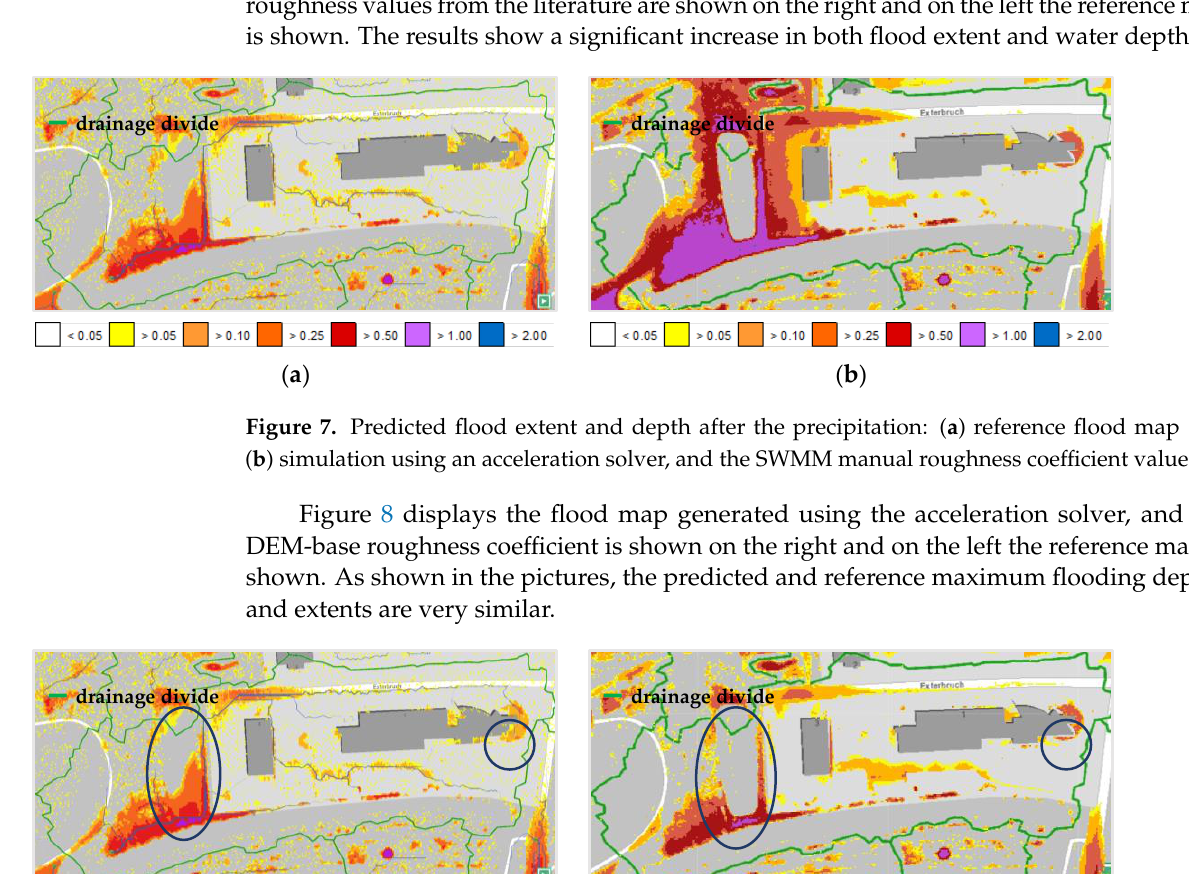
Figure 6. Predicted flood extent and depth after the precipitation: ( a ) reference flood map [30]; ( b ) simulation using Roe solver with the DEM-base roughness coefficient values.